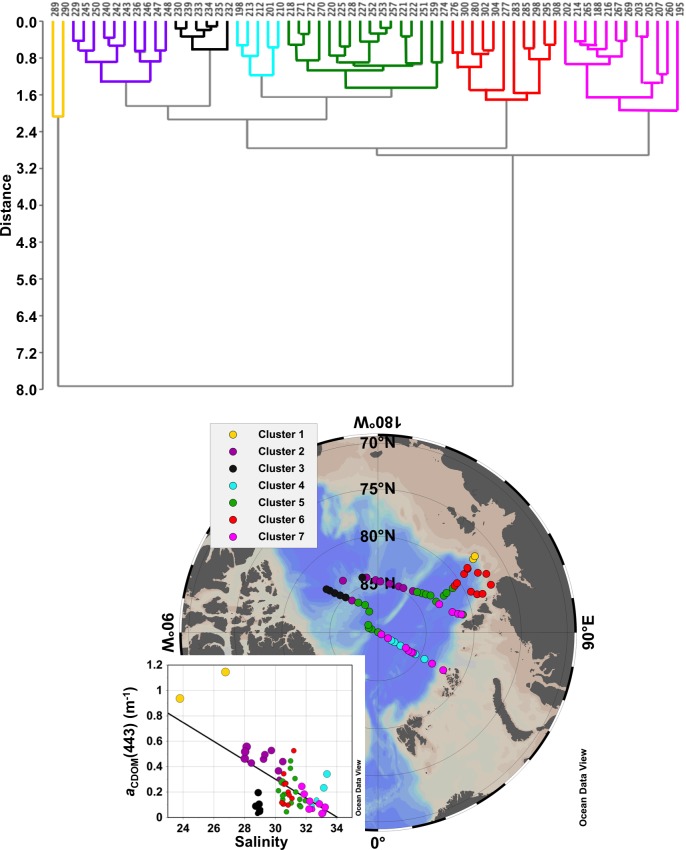
Clustering based on environmental matrix.(top) Dendogram (cophenetic correlation coefficient: c = 0.91) for sampling stations based on surface normalized values of an environmental matrix containing hydrographic and IOP parameters: temperature, salinity, aCDOM(443), aNAP(443) and aph(443). (bottom) ODV map [44] showing the position of each station according to the classification based on the hierarchical clustering. Inset graph shows the correlation between aCDOM(443) and salinity colored with respect to the clusters; black line indicates the best fit (p<0.01).